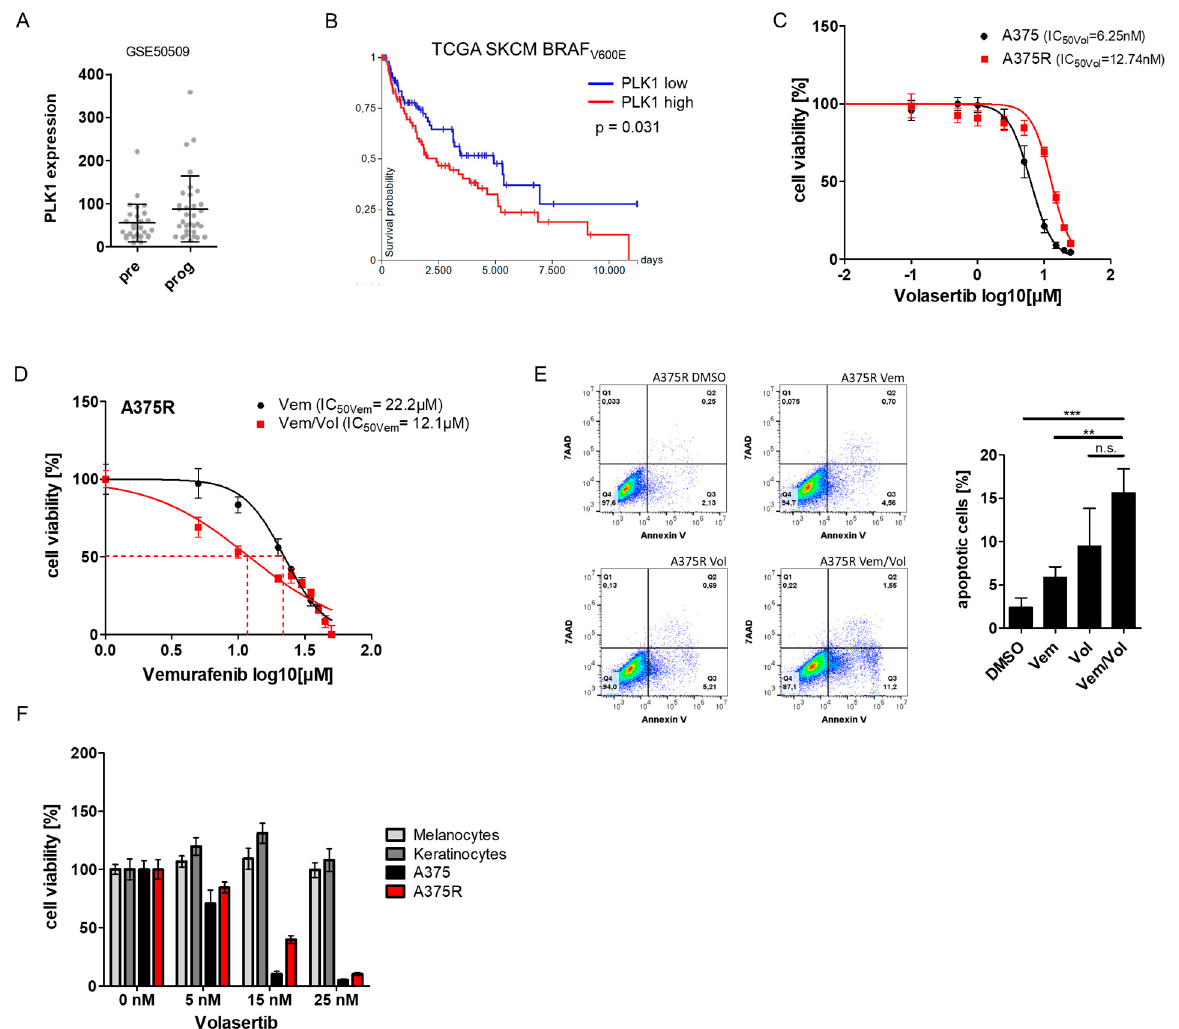
Figure 6. PLK1 is associated with tumor progression and poor survival and offers a suitable target for melanoma therapy. ( A ) Analysis of PLK1 expression in the dataset GSE50509 comparing untreated melanoma samples and samples at tumor progression during BRAFi treatment. ( B ) Kaplan–Meier plot of PLK1 (red = high expression, blue = low expression) in BRAF V600E -mutated melanoma (TCGA). ( C ) Viability assay of A375 cells and A375R cells treated with increasing concentrations of PLK1 inhibitor volasertib. ( D ) Cell viability of A375R cells treated with vemurafenib alone or vemurafenib and volasertib (10 nM). ( E ) Analysis of apoptosis for A375R cells treated with DMSO, vemurafenib (10 µM), volasertib (10 nM) or vemurafenib and volasertib. ( F ) Cell viability of A375 cells, A375R cells, as well as normal melanocytes and normal keratinocytes incubated with increasing concentrations of volasertib (0-25 nM). (** p < 0.01; *** p < 0.001; n.s.: not significant) .